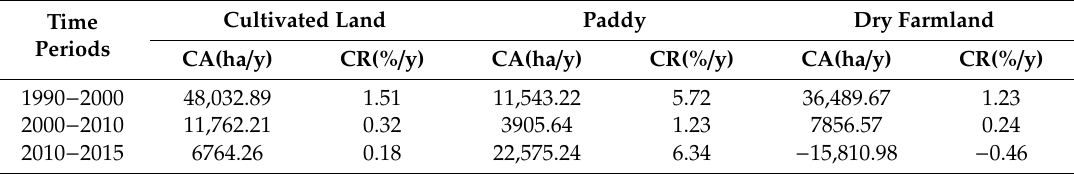
Table 1. Change area and change rate of cultivated land during different time periods.